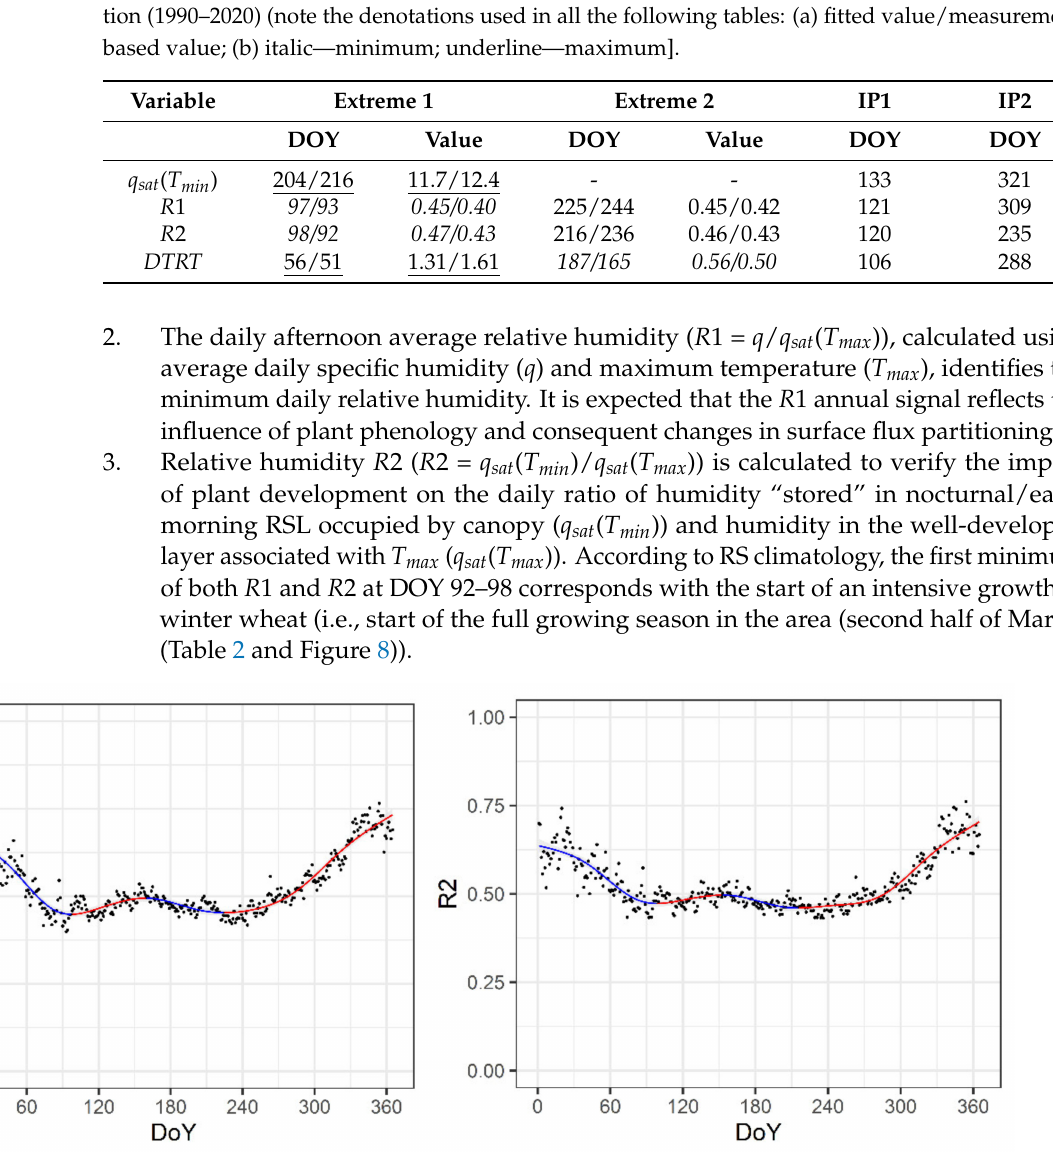
Figure 8. For the period 1990–2020, daily averages of R 1 and R 2 for RS climate